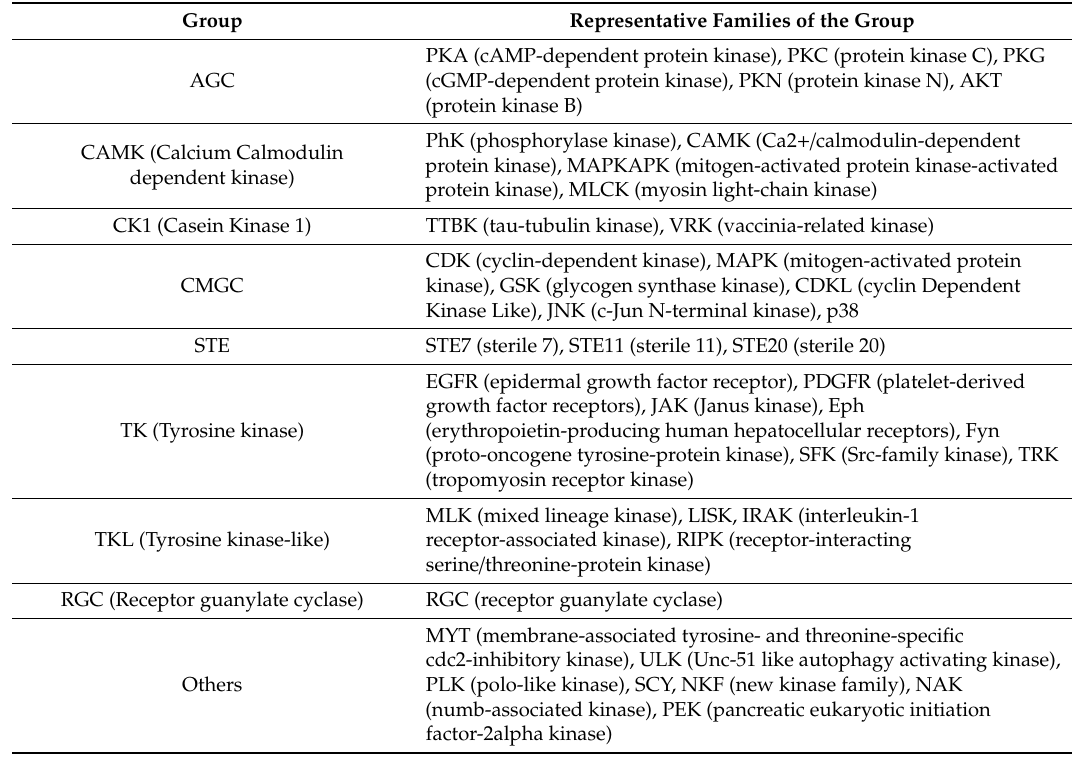
Table 1. Classification of eukaryotic protein kinases (ePKs).